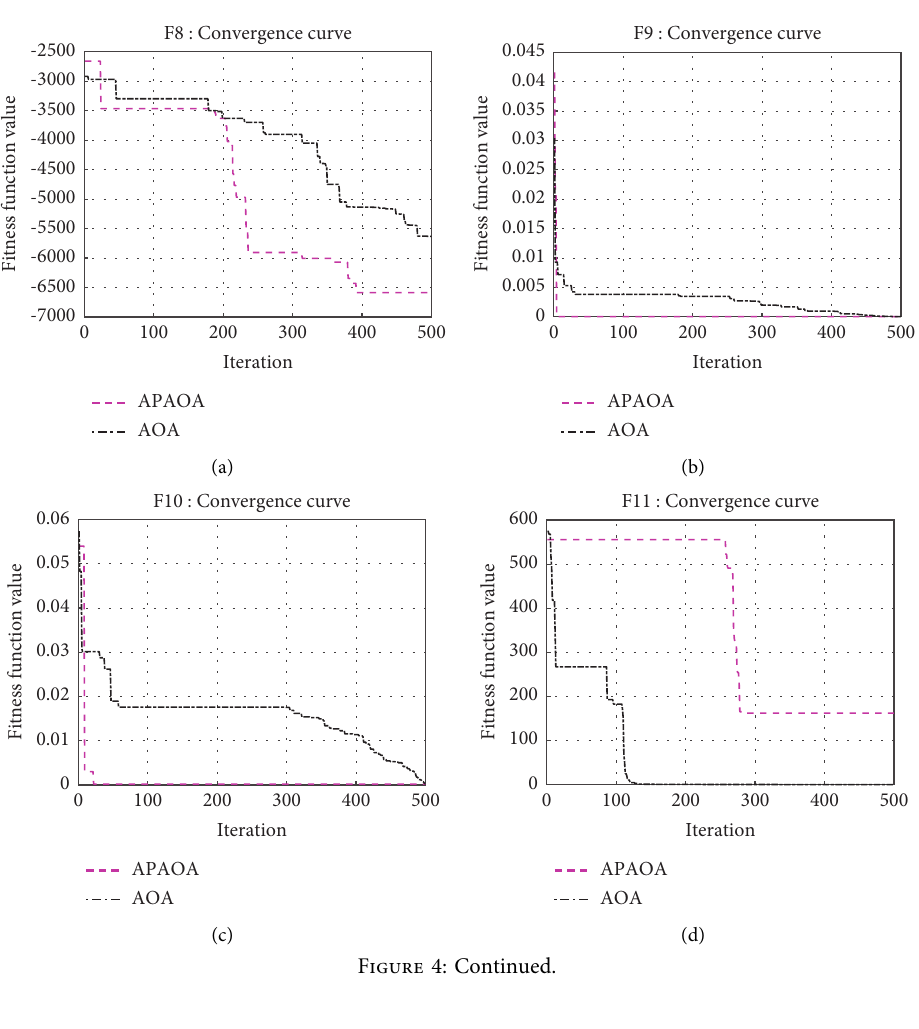
F8 : Convergence curve F9 : Convergence curve